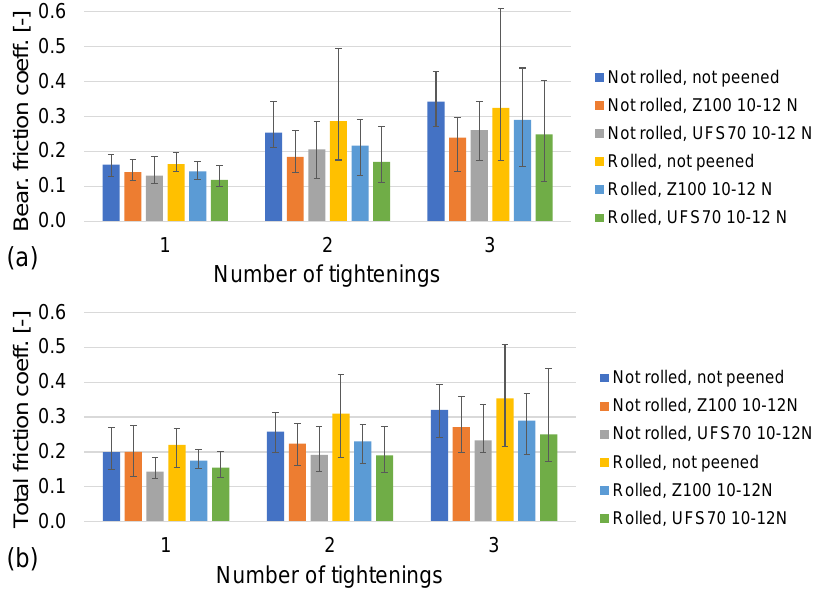
Figure 3. ( a ) Bearing and ( b ) total friction coefficients retrieved during the tests in dry conditions. Table 7. Analysis of variance (ANOVA) table with regard to the bearing friction coefficient ( b ) in dry conditions.